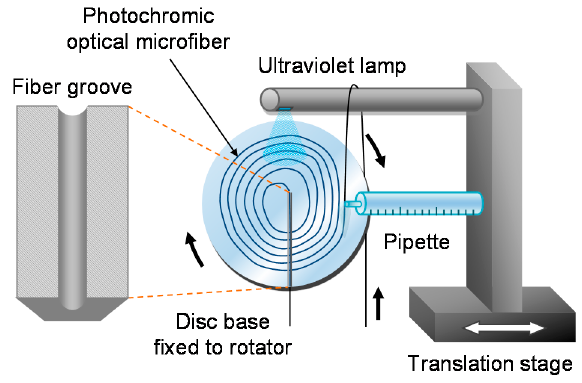
Figure 22. Schematic diagram of the coiling rig used during the construction of the sensor head.